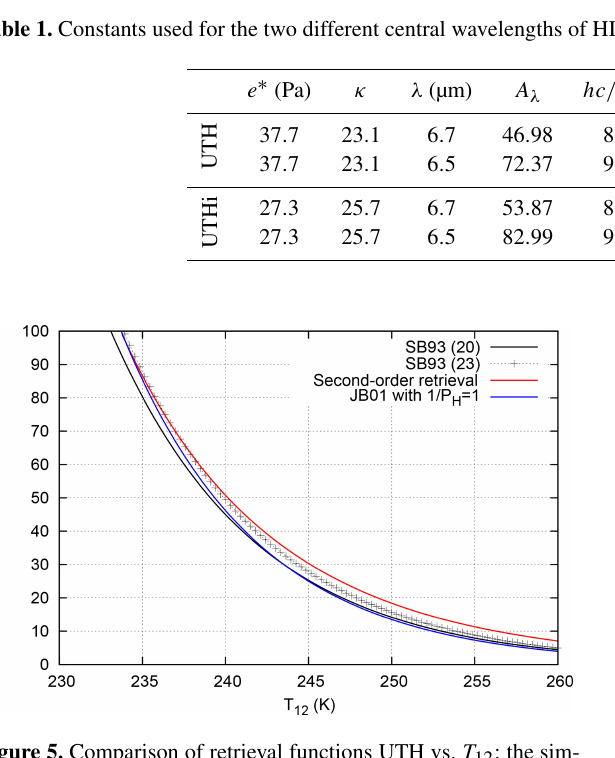
Figure 5. Comparison of retrieval functions UTH vs. T 12 : the sim- ple black line is the original function from SB93 (Eq. 20); the black line with crosses is their Eq. (23). The blue line is the improved SB93-type retrieval from JB01, shown here without the correction for lapse rate variability (i.e. 1 /P H = 1), and the red curve repre- sents the second-order retrieval.